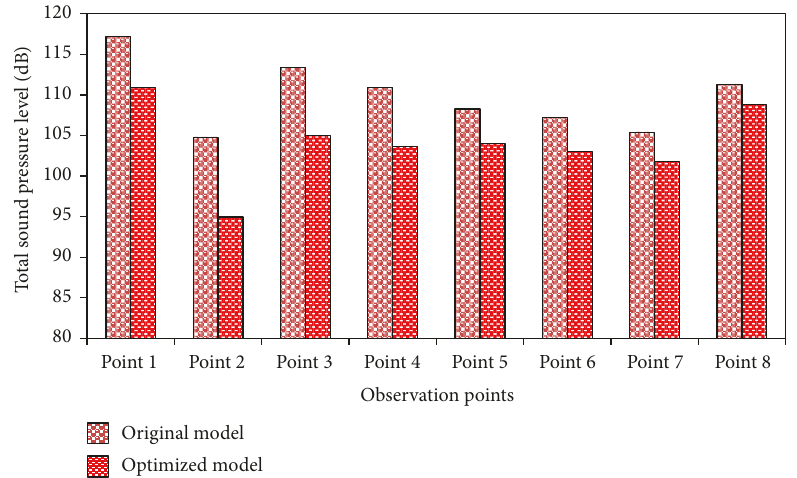
Figure 11: Comparison of total noise of observation points before and after optimization.